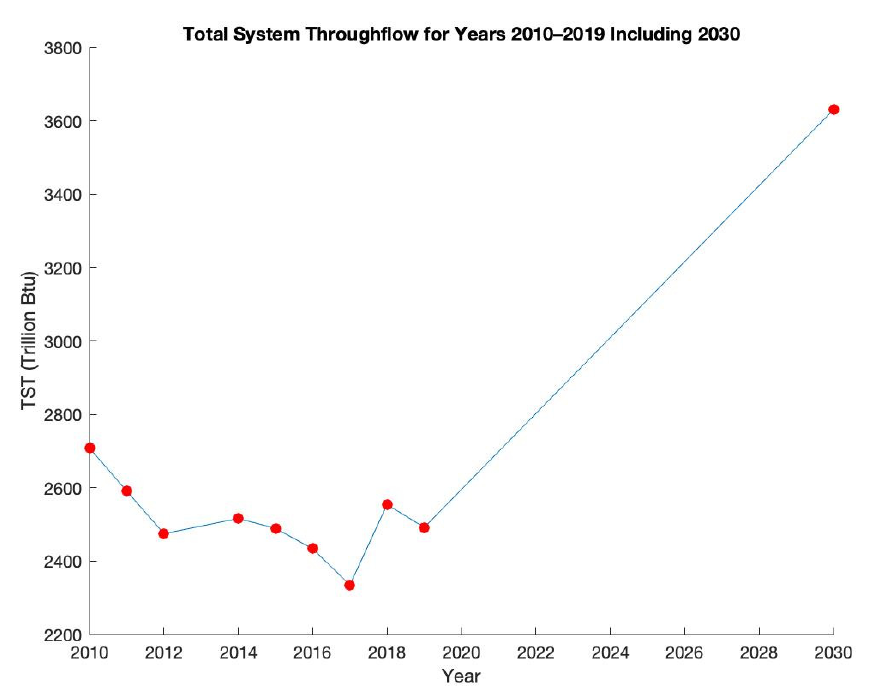
Figure 8. TST for Maryland’s energy industry from 2010–2019 including a simulated 2030.